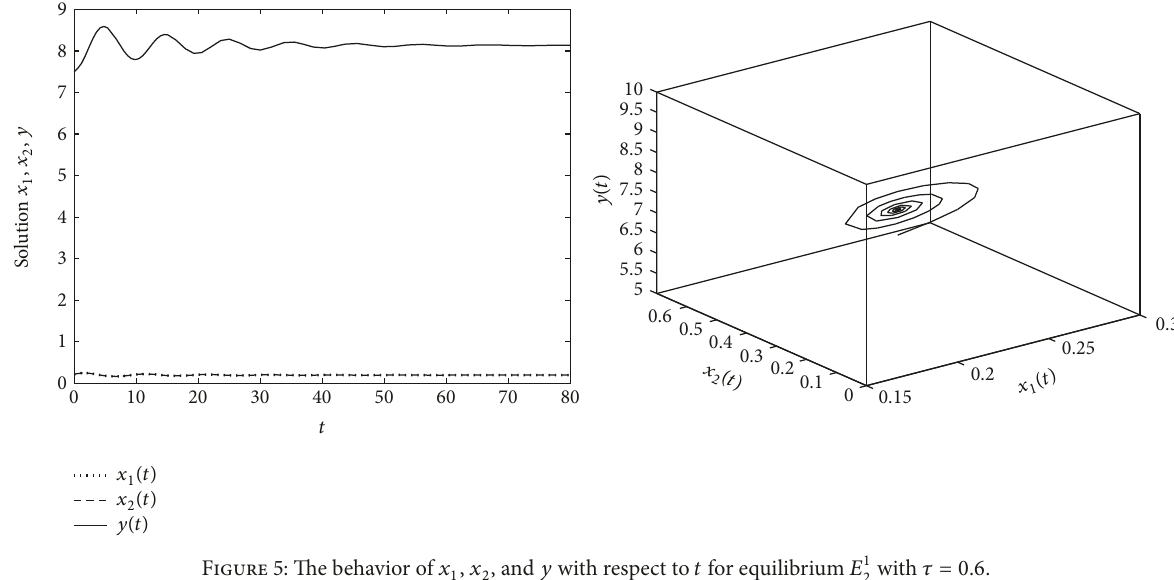
Figure 5: The behavior of 𝑥 1 , 𝑥 2 , and 𝑦 with respect to 𝑡 for equilibrium 𝐸 1 2 with 𝜏 = 0.6 .